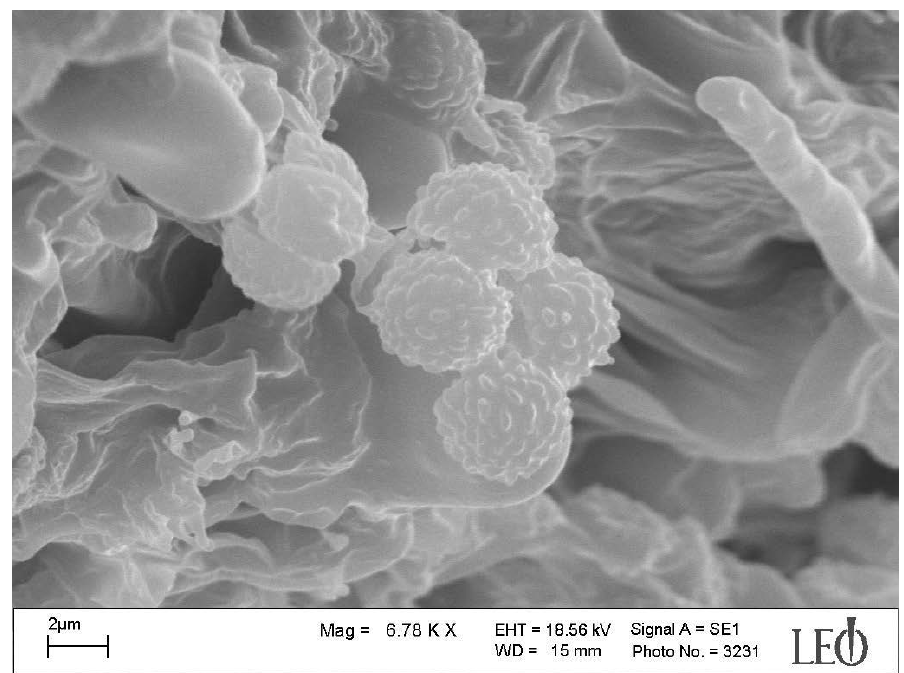
Fig. 3. Minutely verrucose spores of Gloiodon strigosus (SEM x 6,78 KX) (Courtesy of Lab. Electron & Confocal Microscopy, Adam Mickiewicz University,